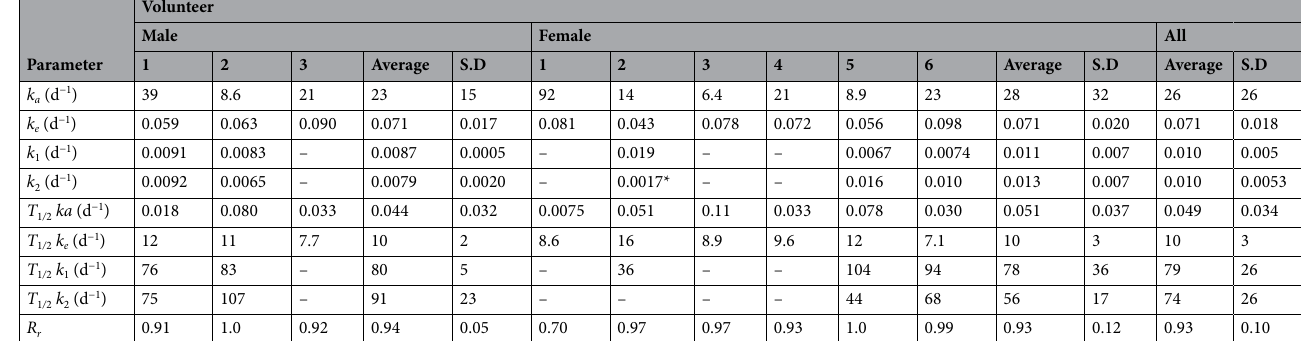
Table 1. Estimated parameters of HDO model for each D 2 O administered volunteer. S.D., standard deviation.